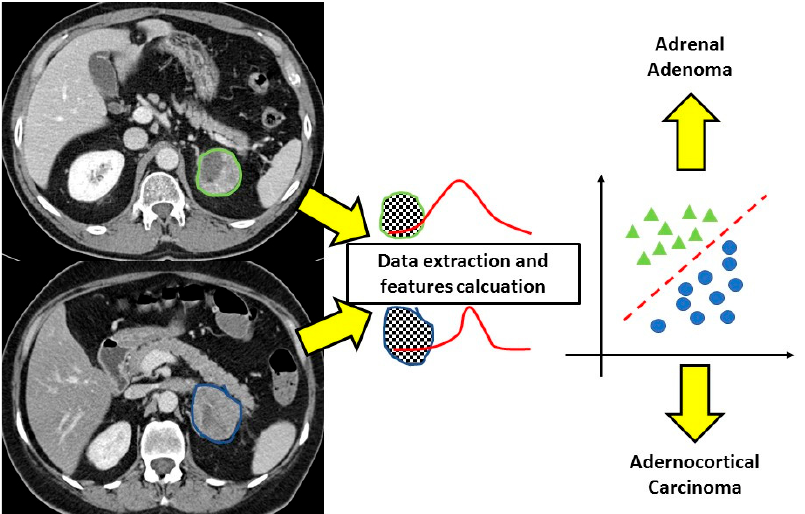
Figure 2. CT texture analysis of adrenal masses. After the contouring of the lesions, the software extracts different features from the regions of interest allowing correct classification of the adenoma and adrenocortical carcinoma that at conventional imaging would not have been